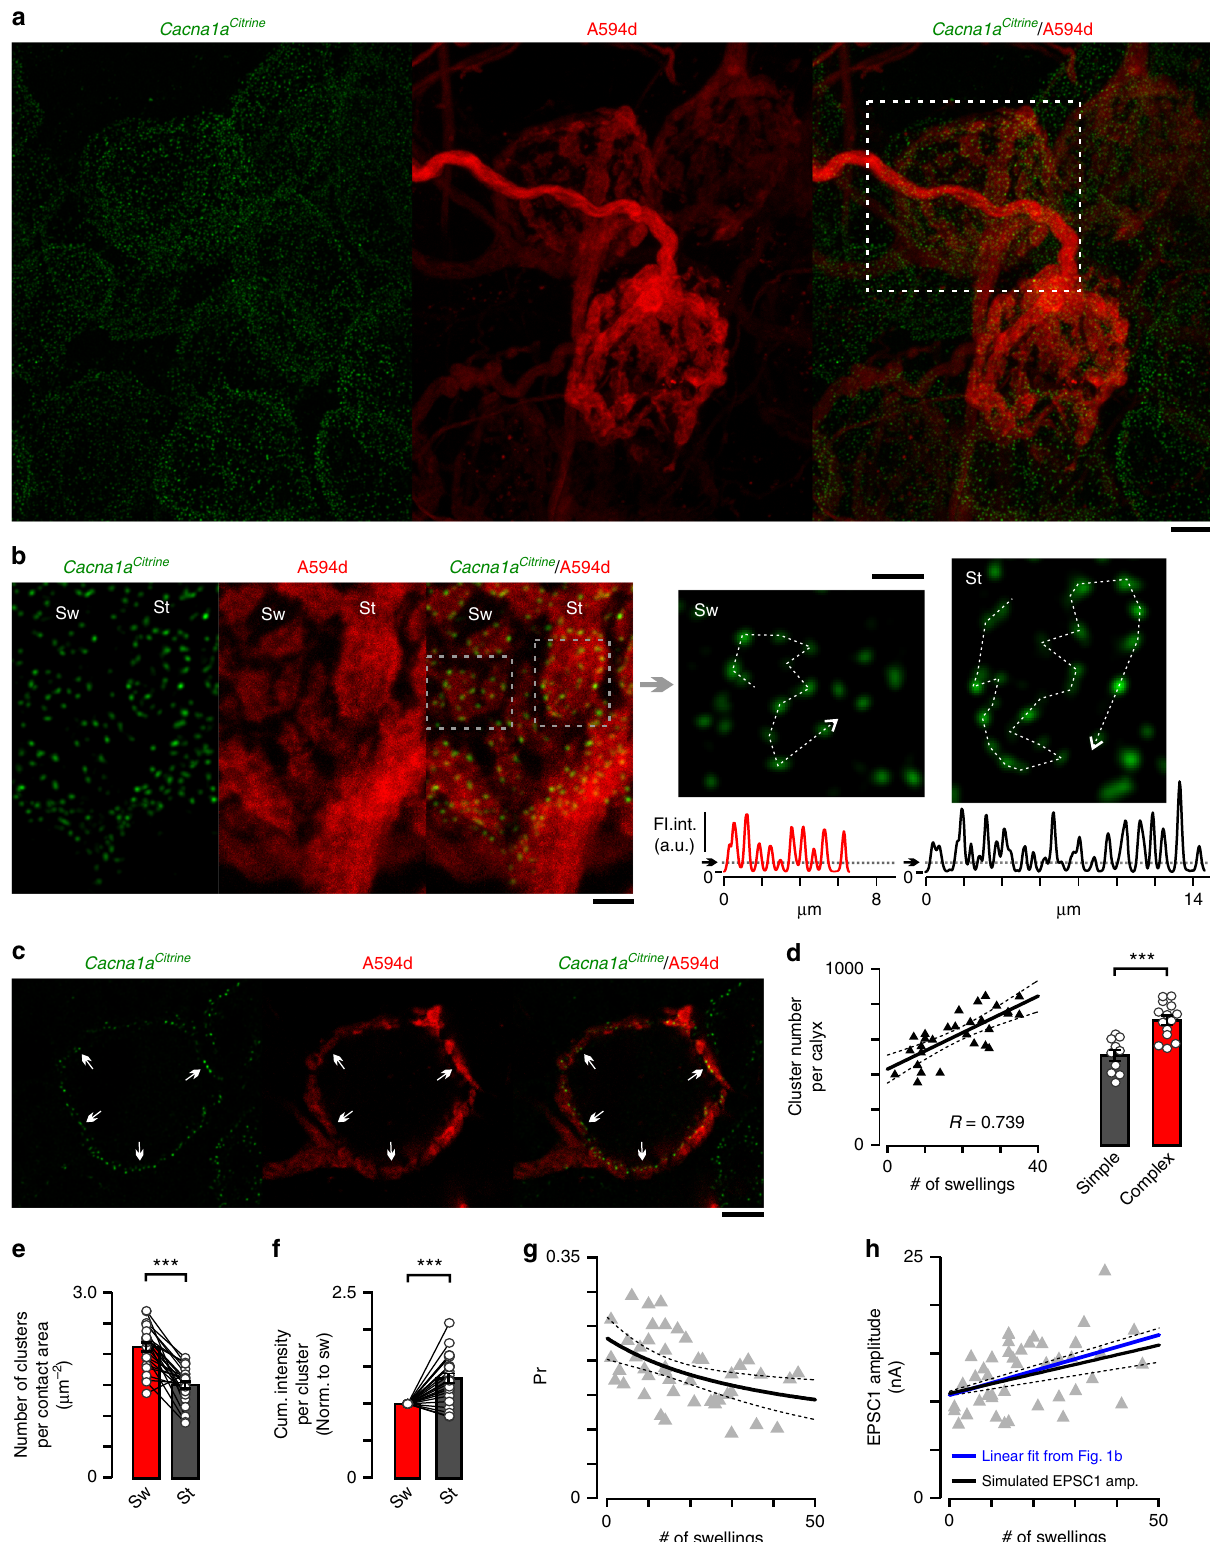
(Supplementary Figure 5a and Supplementary Table 1). We attribute this to the omnipresent high Pr release sites which dominate the fi rst latency to release and thus